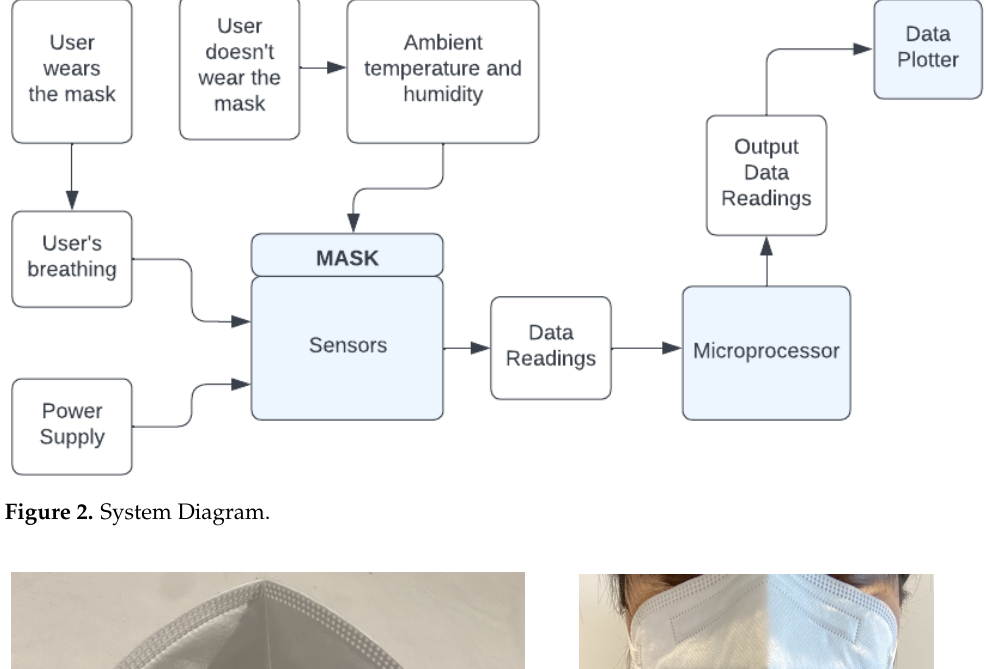
Figure 2. System Diagram.